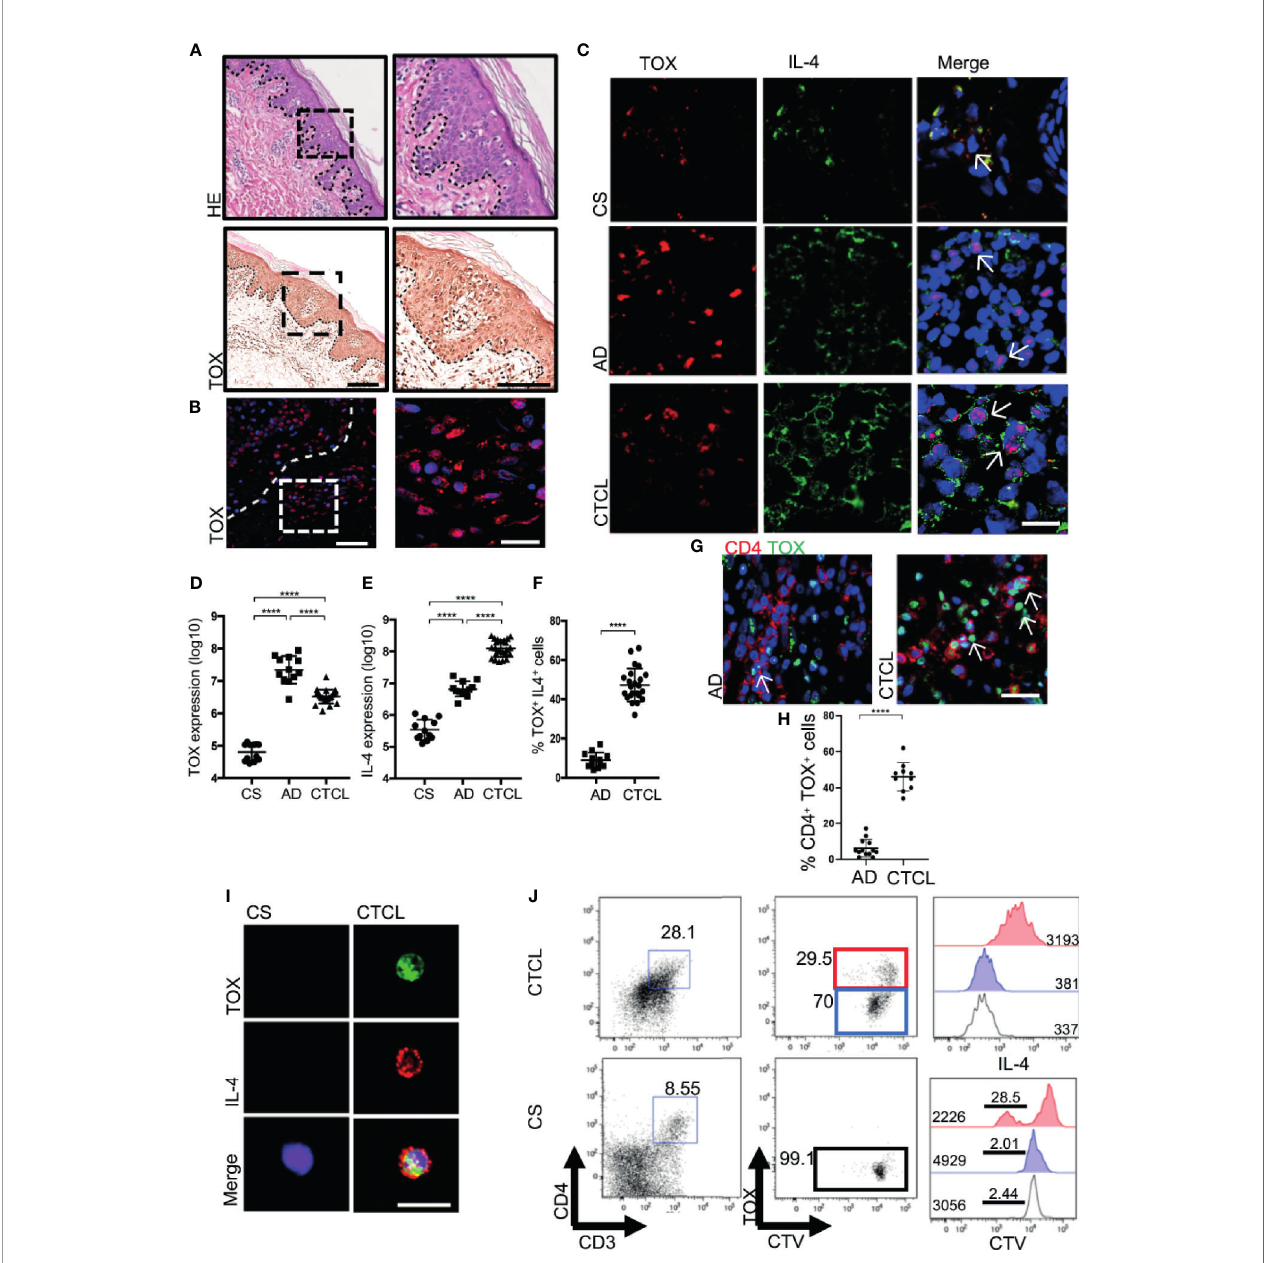
FIGURE 1 | IL-4 is produced by TOX + CD4 + T cells in the skin lesions of early-stage CTCL patients. (A) Hematoxylin-eosin (HE) staining and immunohistochemistry (IHC) of TOX in CTCL plaques. (B) Representative immuno fl uorescence (IF) of TOX (AF-594) in the Pautrier microabscesses area of CTCL plaques. (C) Representative IF of TOX (AF-594) and IL-4 (AF-488) in CTCL plaques, AD and CS. Quanti fi cation of the total expression of (D) TOX, (E) IL-4 and (F) percentage of TOX + IL-4 + cells in the microphotographs of CTCL plaques (n = 23), AD (n = 12) and CS (n = 12). (G) Representative IF of TOX (AF-488) and CD4 (AF-594) in CTCL plaques and AD. Quanti fi cation of the percentage of (H) CD4 + TOX + cells in the microphotographs of CTCL plaques (n = 23) and AD (n = 2). (I) Representative IF of TOX (AF-488) and IL-4 (AF-594) in CD4 + cells isolated from CTCL plaques and CS (n = 5). (J) Representative plot of proliferating CellTrace Violet (CTV) TOX + cells and histogram of IL-4 and CTV from TOX + and TOX - cells gated on CD4 + cells (n = 4). Bar graph of IL-4 MFI from TOX - cells (blue, CS) and TOX + cells (red, CTCL). The dotted line in A and B indicates the dermoepidermal junction. Arrows indicate coexpression of markers in the different staining. Error bars = SEM. ****P < 0.0001. Scale bars= 20